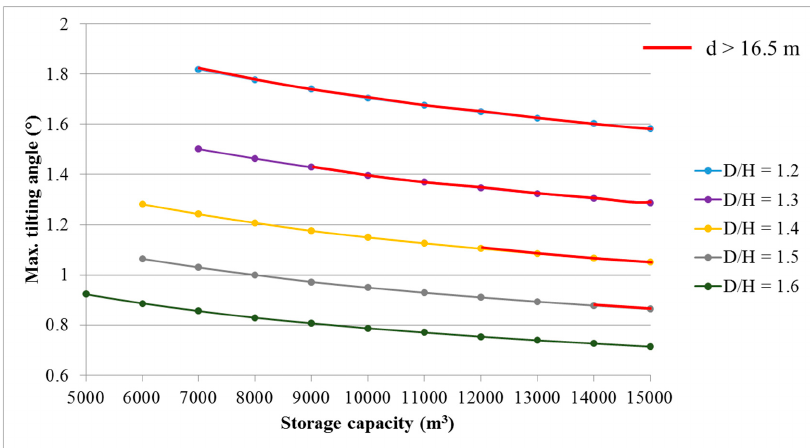
Figure 30. Use of syntactic foam as floaters: ( a ) configuration and ( b ) bottom plate.